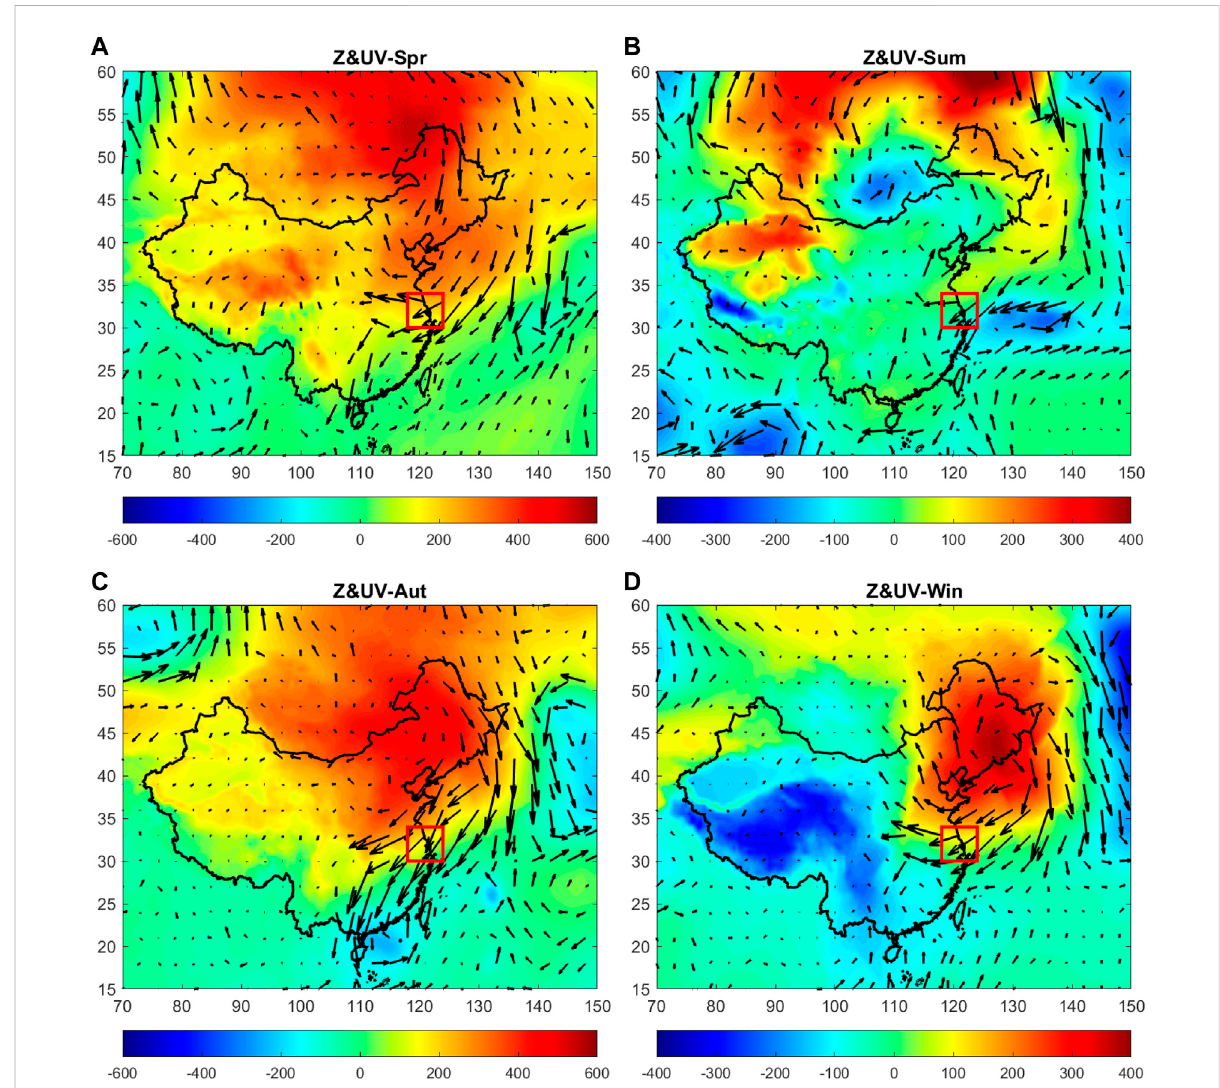
FIGURE 5 The same as in Figure 4 but for the Type-two events. The solid red box marks the location of Shanghai. And the results are shown for (A) spring, (B) summer, (C) autumn, (D)